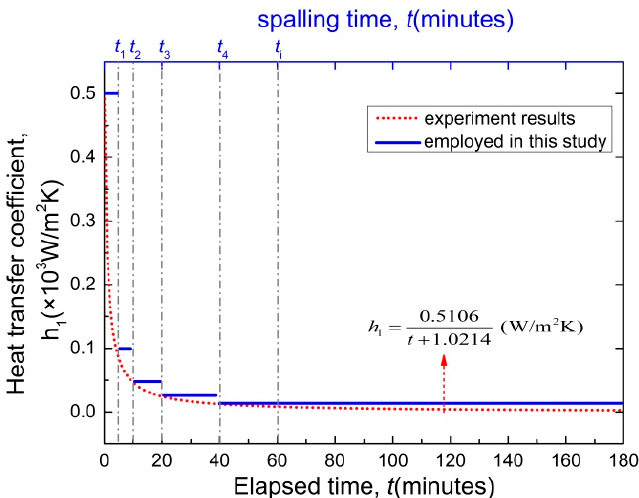
Figure 11. Heat transfer coefficient employed in this analysis.